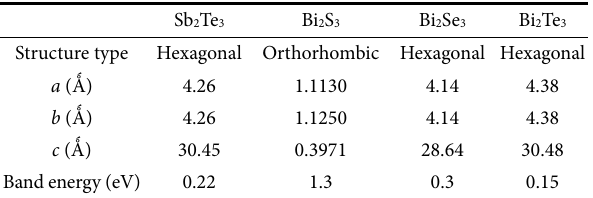
Table 1 Physical properties of M 2 C 3 (M = Sb, Bi and C = S, Se,